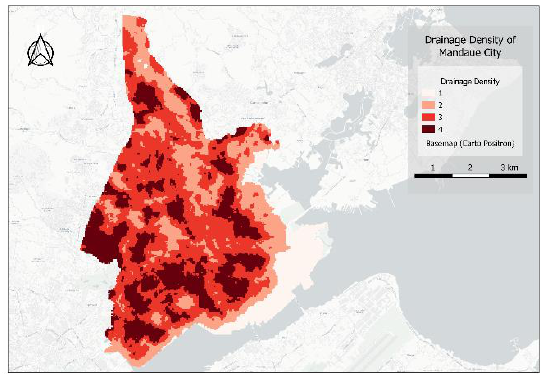
Figure 7. Drainage density map of Mandaue City, Cebu